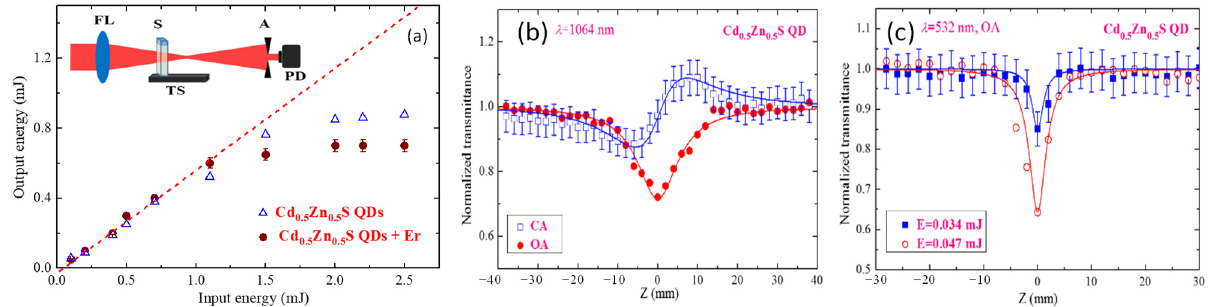
Figure 1. ( a ) OL in Cd 0.5 Zn 0.5 S QDs and Cd 0.5 Zn 0.5 S QDs+erythrosine. Z-scan scheme is presented in the inset. ( b , c ) OA and CA scans of Cd 0.5 Zn 0.5 S QDs using 1064 nm ( b ) and 532 nm ( c ) pulses. Adapted with permission from Ref. [15], 2018, Optica Publishing Group.